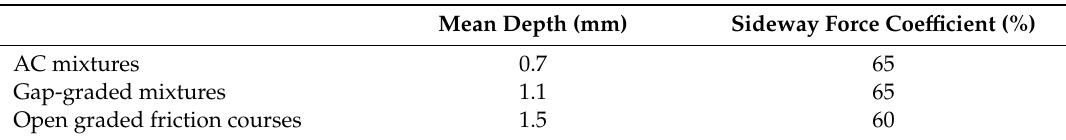
Figure 18. Cracking resistance label.